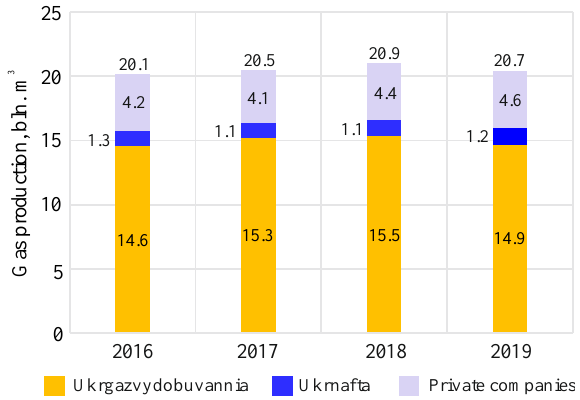
Figure 1. Structure of the gross production of natural gas in Ukraine in 2016–2019.